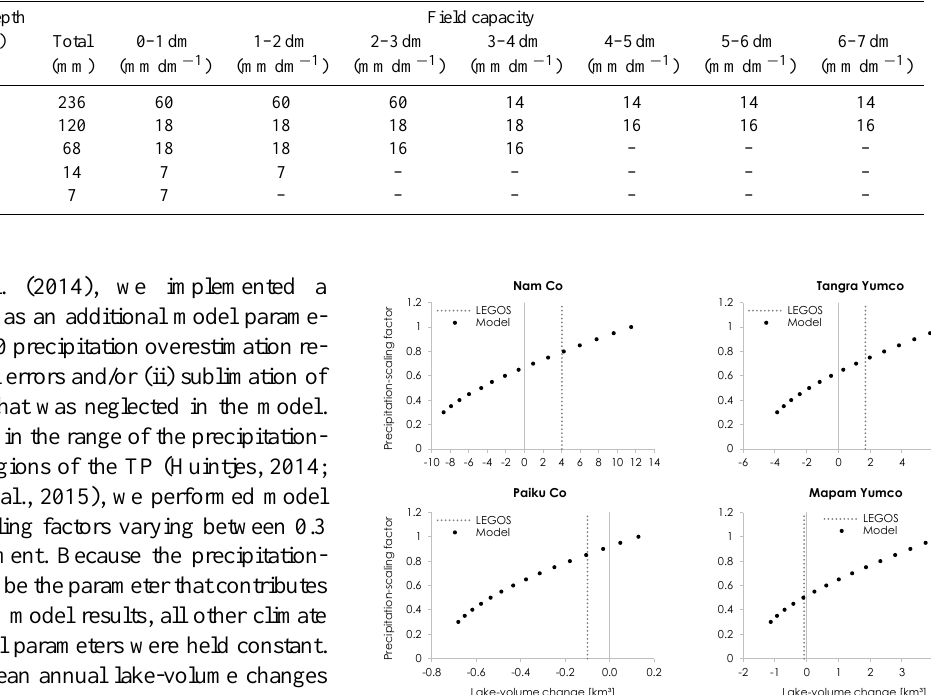
Table 3. Soil parameters used as input for hydrological modeling. Combination land